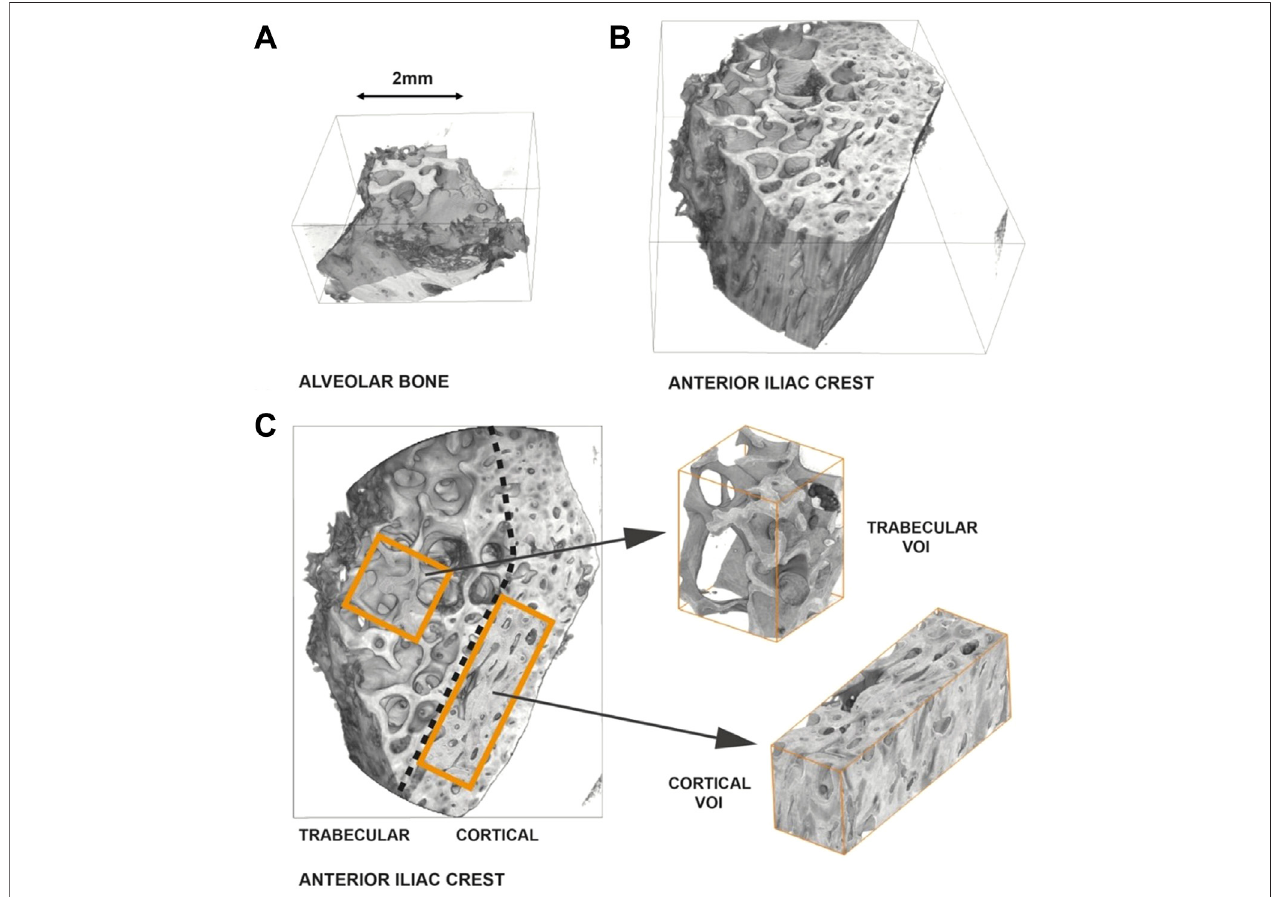
FIGURE1| Representativereconstructionandselectionofvolumesofinterest – SampleP4(AB)/(IC). (A) 3D-renderingofanalveolarbonesample. (B) 3D-rendering ofaniliaccrestsample.TheICsampleisgreaterinsizethan theABsample.Furthermore,the ABprimarilyconsists ofcorticalbone,asopposedtotheICsample, which is clearly composed of a trabecular and a cortical region. (C) Differentiation of the IC sample into a cortical and a trabecular region and de fi nition of volumes of interest (VOIs).